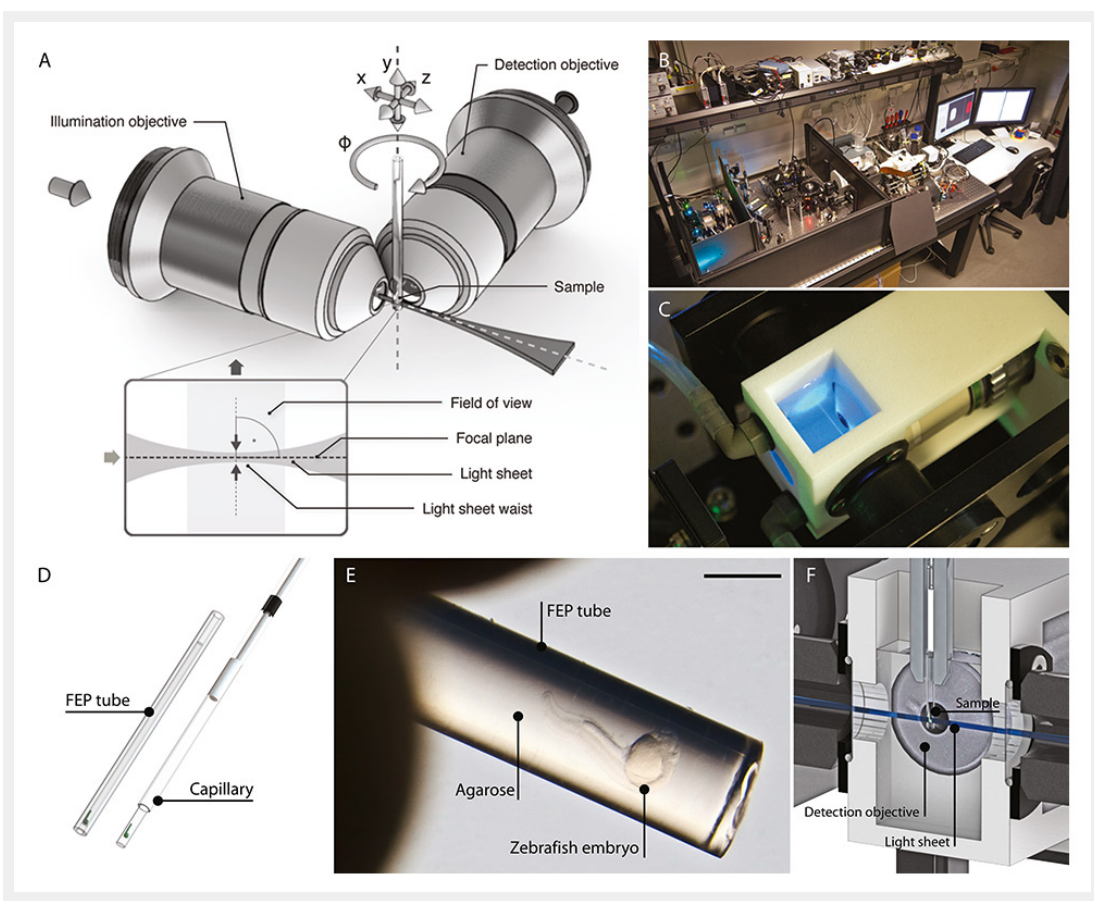
A: The principle of light sheet microscopy. Top: Illumination and detection objectives are oriented orthogonally, and the sample is placed at the intersection of their focal planes. A sheet of laser light illuminates a thin slice of the sample. Bottom: View from top. The light sheet has a waist in the centre of the field of view and overlaps perfectly with the focal plane of the detection objective. B: Custom-built light sheet microscope for imaging and photomanipulation of the zebrafish heart. C: Close-up of the medium-filled sample chamber with a blue light sheet. D: Sample mounting for in vivo cardiac optical mapping. Comparison of zebrafish embryos mounted in fluorinated ethylene propylene (FEP) tube and glass capillary. E: 1 dpf (days post-fertilisation) zebrafish mounted in FEP tube. F: Rendering of a mounted zebrafish embryo held by the sample holder inside the imaging chamber with illumination objectives, light sheet and detection